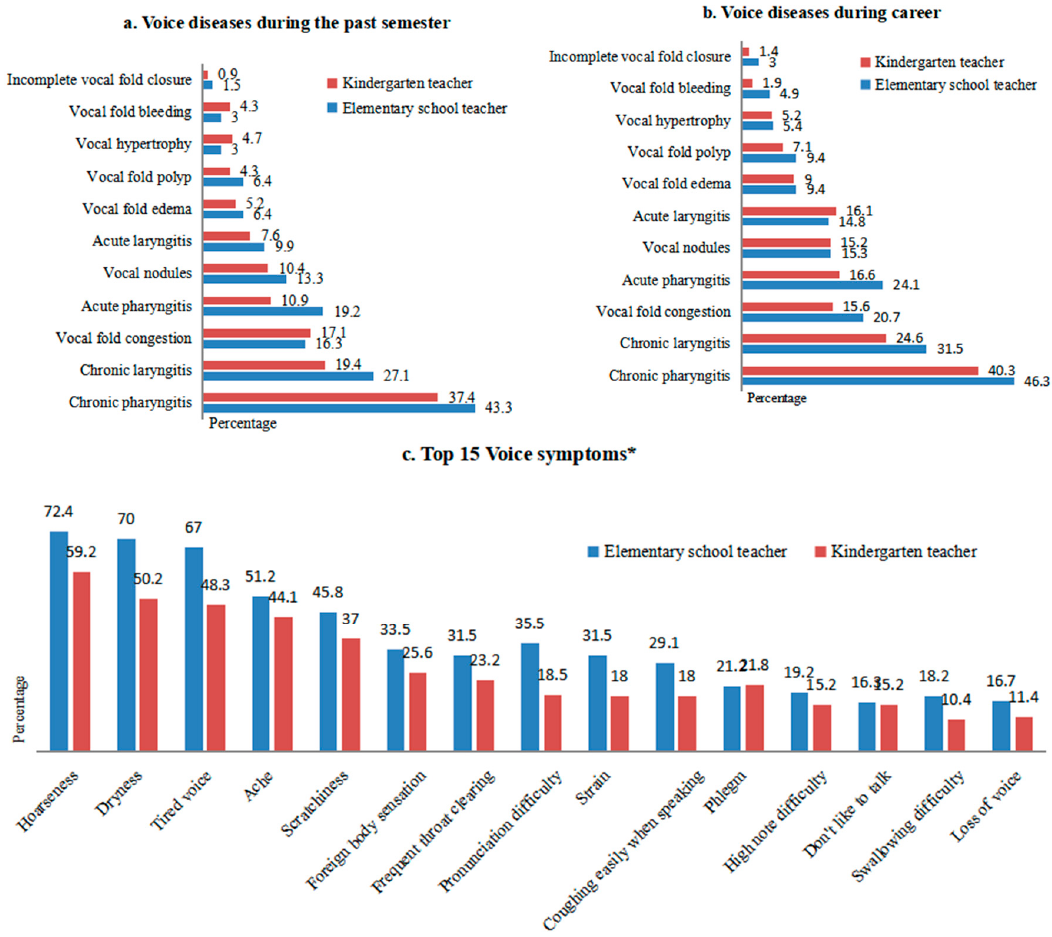
Figure 1. ( a ) Voice diseases during the past semester, ( b ) Voice diseases during career, ( c ) Top 15 Voice symptoms. Comparison of voice diseases and voice symptoms between kindergarten and elementary school teachers, Yancheng City, Jiangsu Province, China (2019), n = 414. Note: * Teachers were asked